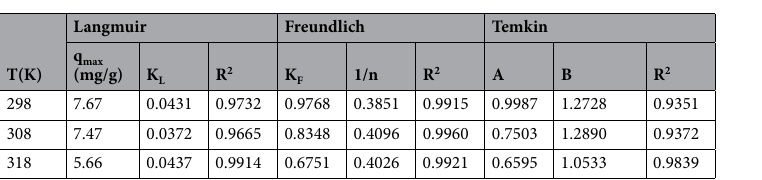
Table 3. Parameters of the isotherm